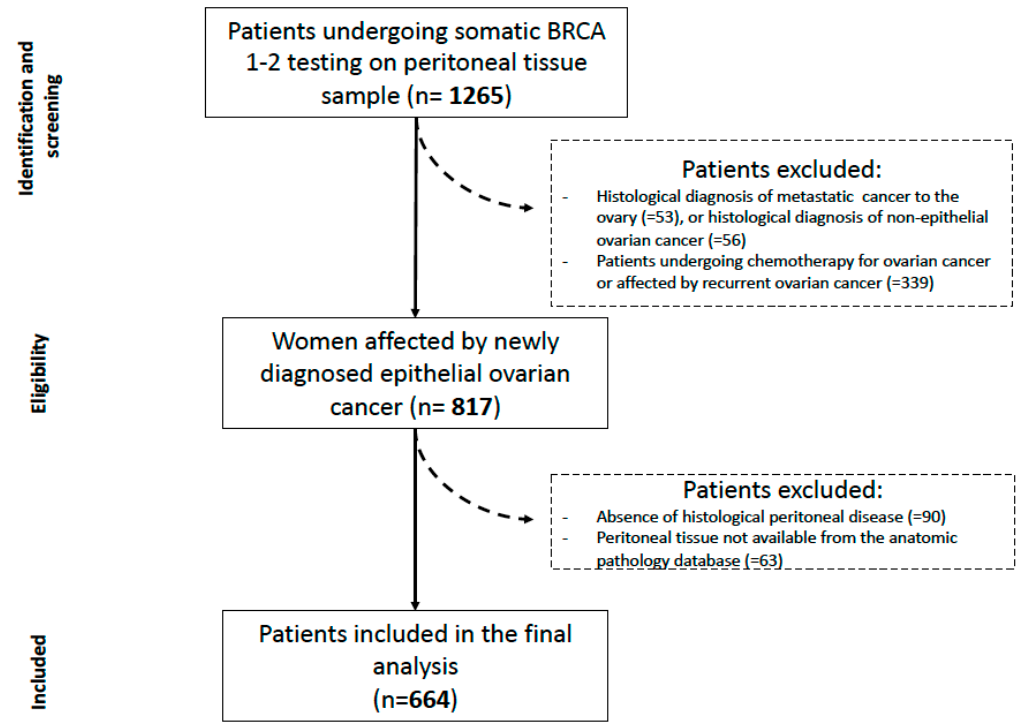
Figure 1. Flowchart of the study.